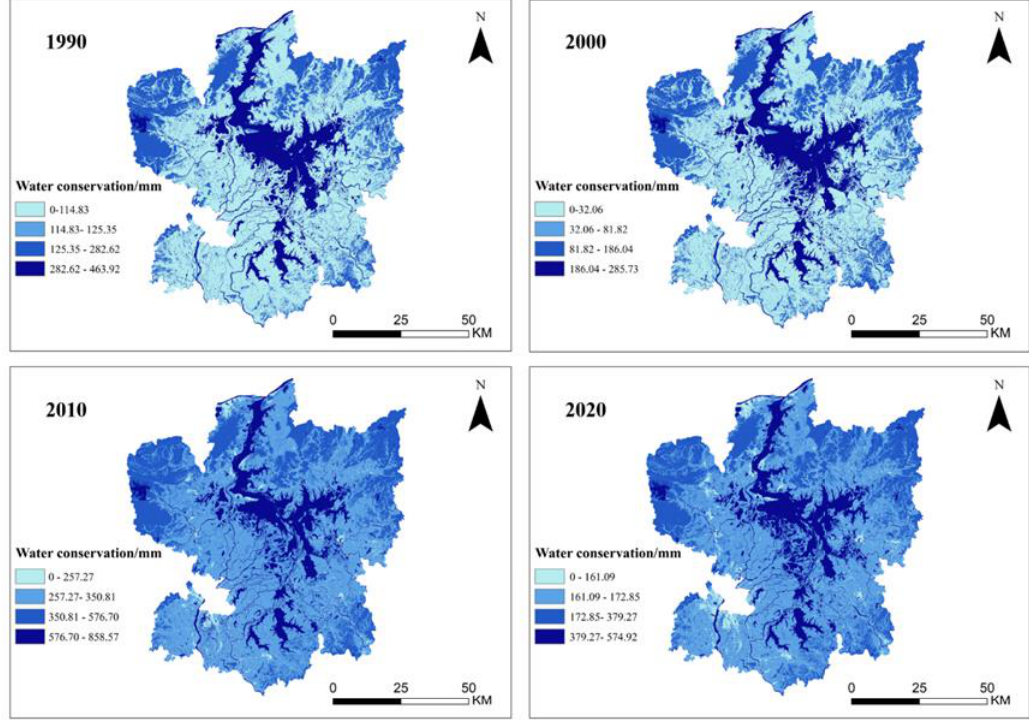
Figure 7. Spatial distribution of water conservation during 1990 – 2020.